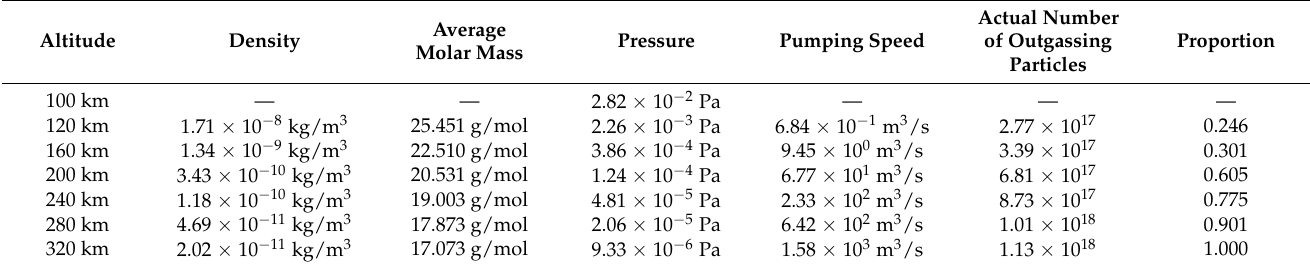
Table 11. Data related to outgassing at different altitudes under the MM